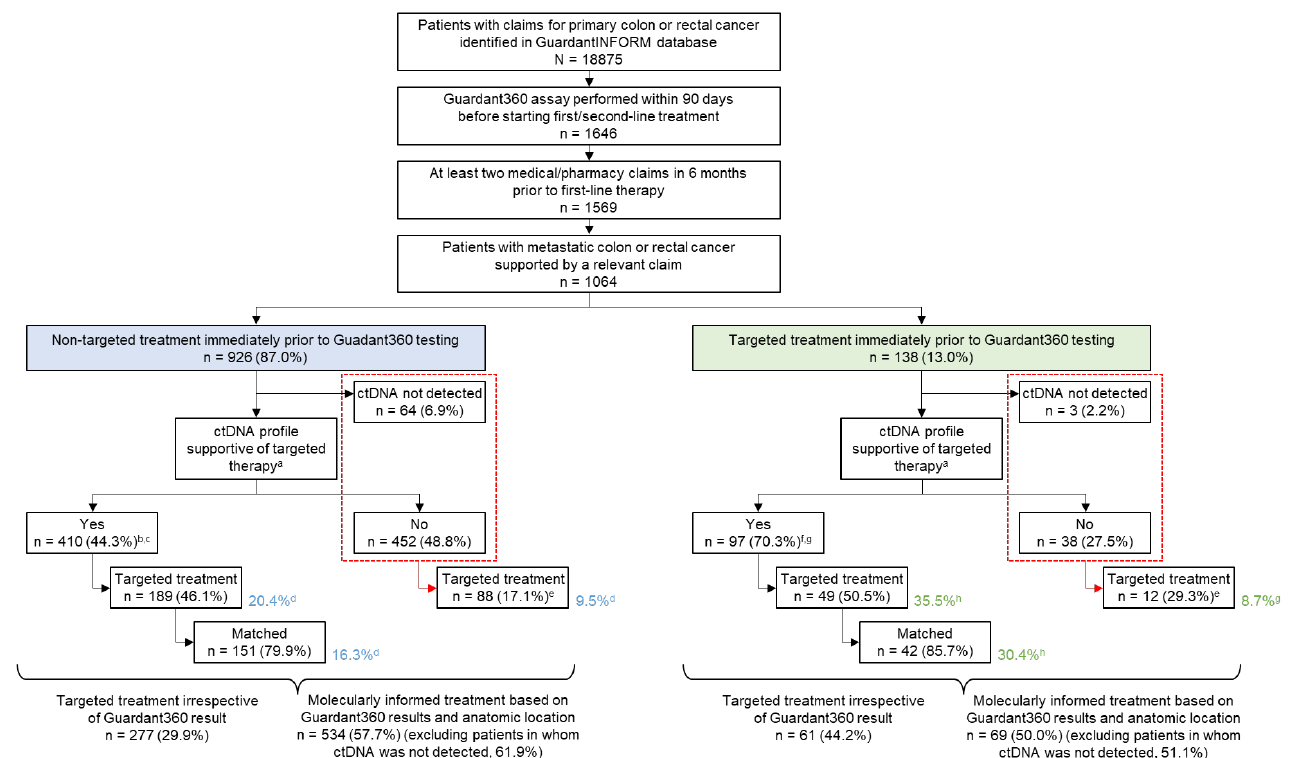
Figure 1. Disposition of patients. Percentages were calculated using the value in the preceding box as the denominator. a Presence of OncoKB level 1–2 or lack of R1; b 47.6% of samples with ctDNA present; c Excludes 48 patients with right-sided mCRC and RAS wild-type only; d Percentage calculated using non-targeted treatment (blue shaded box) as the denominator; e Percentage calculated using ‘No’ and ‘ctDNA not detected’ (outlined with red dashed box) as the denominator; f 71.9% of samples with ctDNA present; g Excludes 9 patients with right-sided mCRC and RAS wild-type only; h Percentage calculated using targeted treatment (green shaded box) as the denominator; Matched, patients who received a treatment matched to the molecular alterations revealed by the ctDNA assay; targeted, patients who received a molecularly targeted treatment.